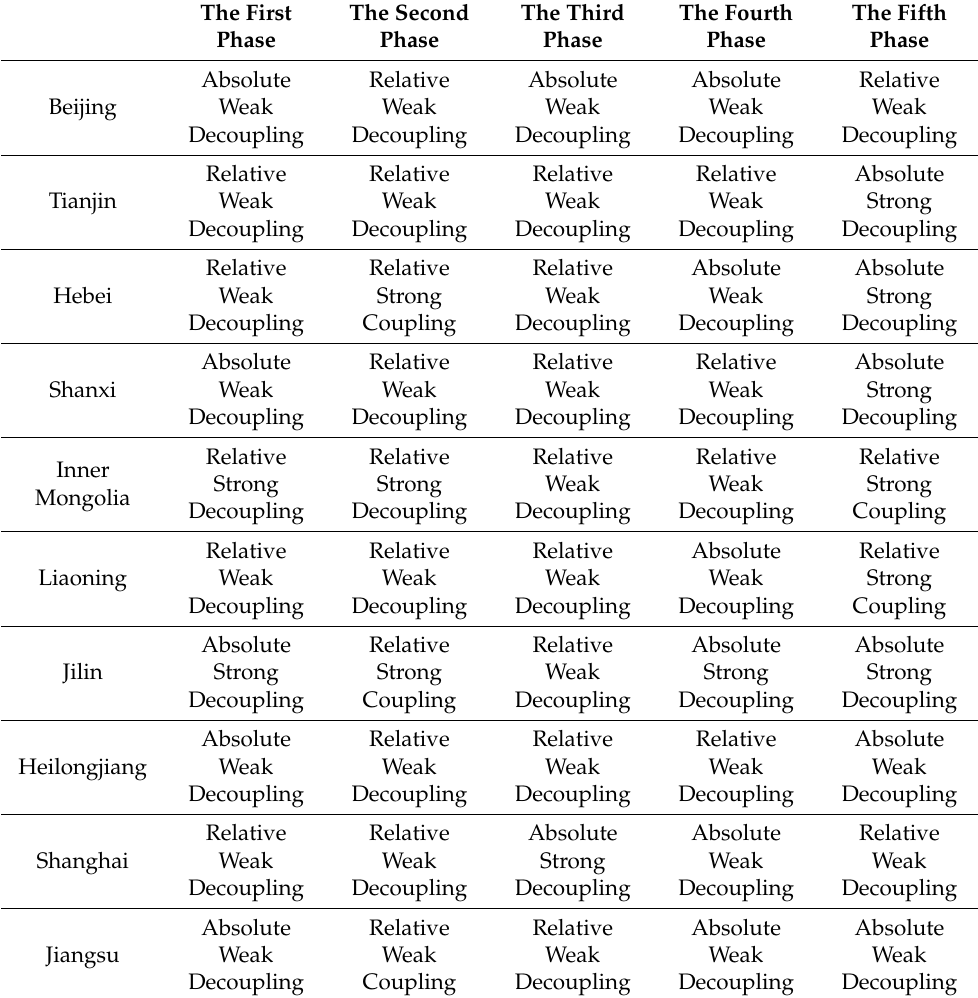
Table 4. The decoupling types for each province in five